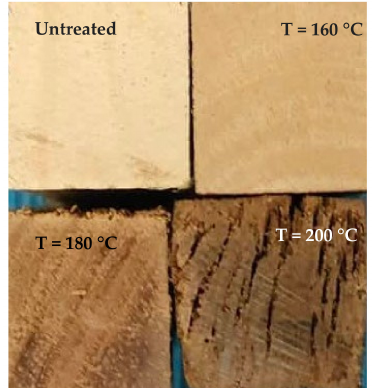
Figure 5. Visual appearance of untreated and treated rubberwood at different